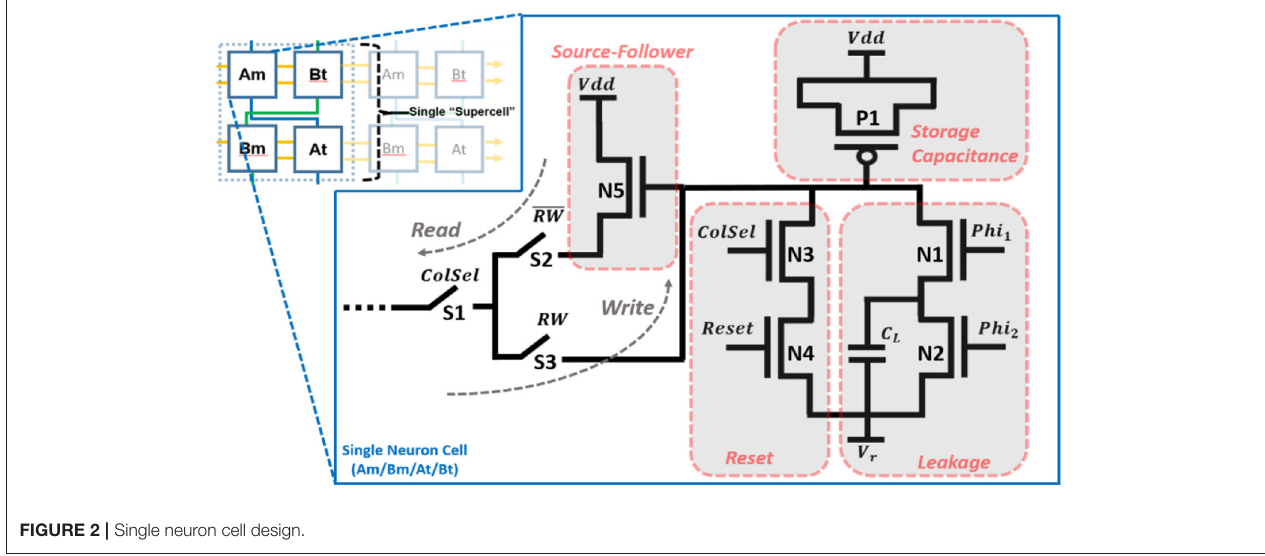
FIGURE 2 | Single neuron cell design.